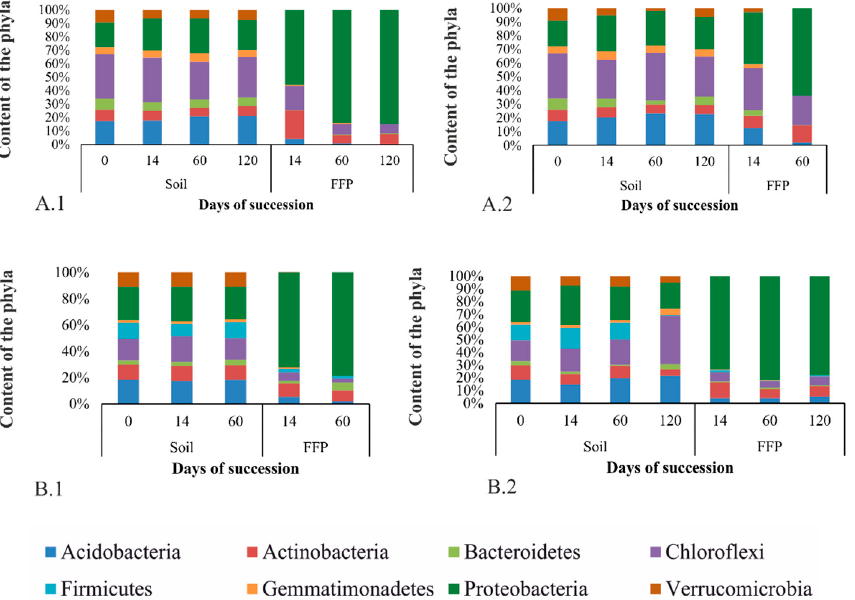
Figure 5. Distribution of bacterial phyla in the samples during succession (only phyla with content greater than 2% are presented). ( A1 )—BB 63–58 AT, 5 ◦ C; ( A2 )—BB 63–58 AT, 20 ◦ C; ( B1 )—BB 63–58 AB, 5 ◦ C; ( B2 )—BB 63–58 AB, 20 ◦